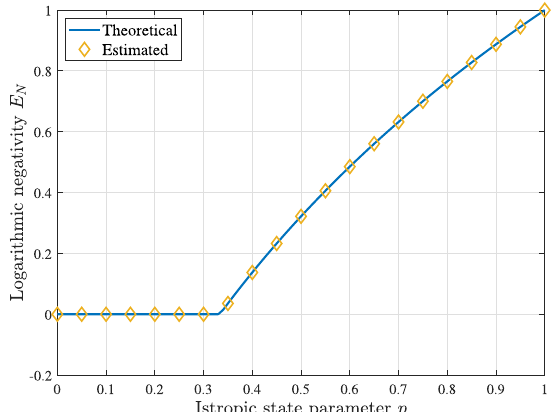
Fig. 8 Numerical results on the two-qubit isotropic states. The blue line represents the precisely calculated logarithmic negativity of isotropic states with parameter p ∈ [0, 1]. The yellow markers depict the estimated logarithmic negativities by simulations of Algorithm 4 on selected isotropic